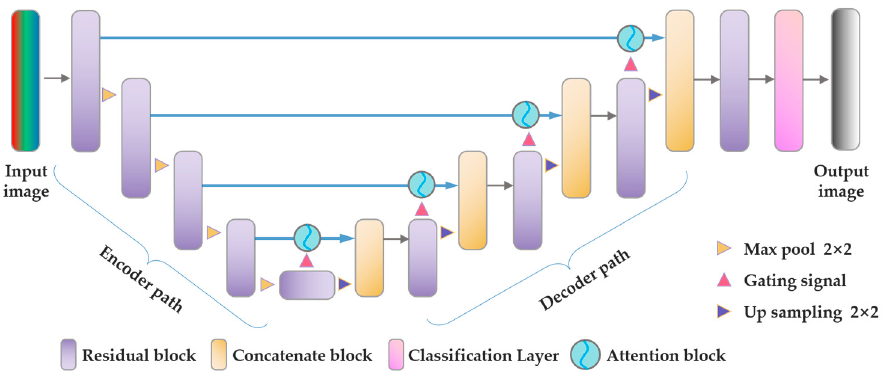
Figure 3. Architecture of the modified Res-UNet.